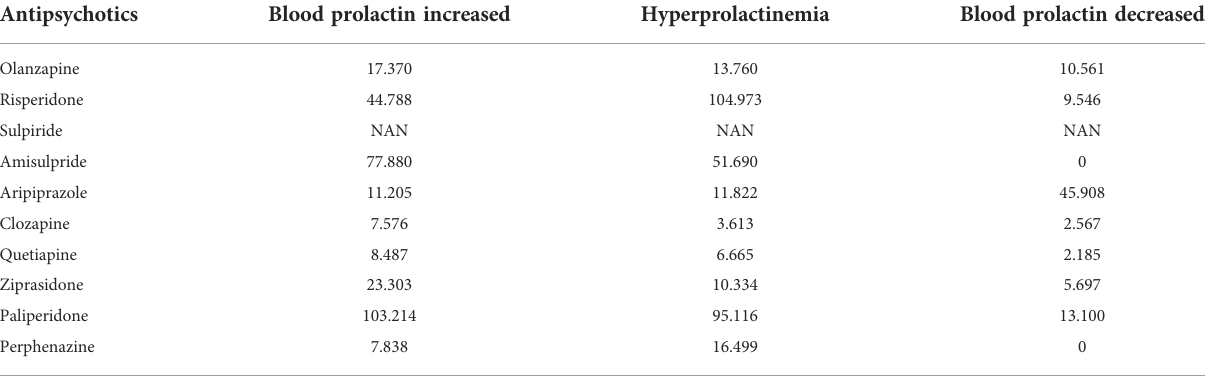
TABLE 4 Relative reporting ratios (RRR) of prolactin (PRL)-related adverse events for a given list of antipsychotics.